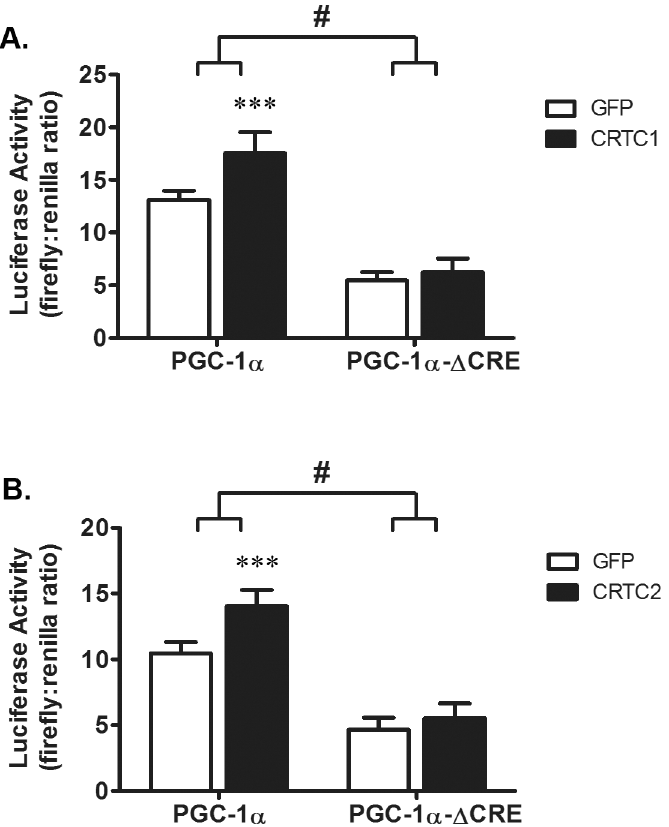
Fig 4. Overexpression of CRTC proteins increase PGC-1 α transcription. L6 myoblasts were transfected with either pPGC-1 α -Luc or pPGC-1 α - Δ CRE-Luc. After 24 h, cells were infected with adenoviruses to